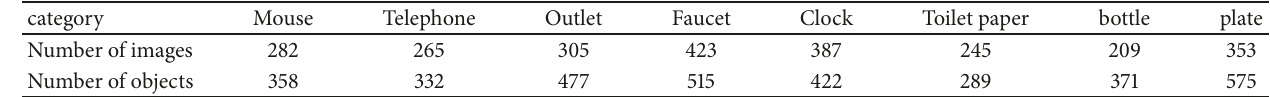
Table 3: The small object dataset.